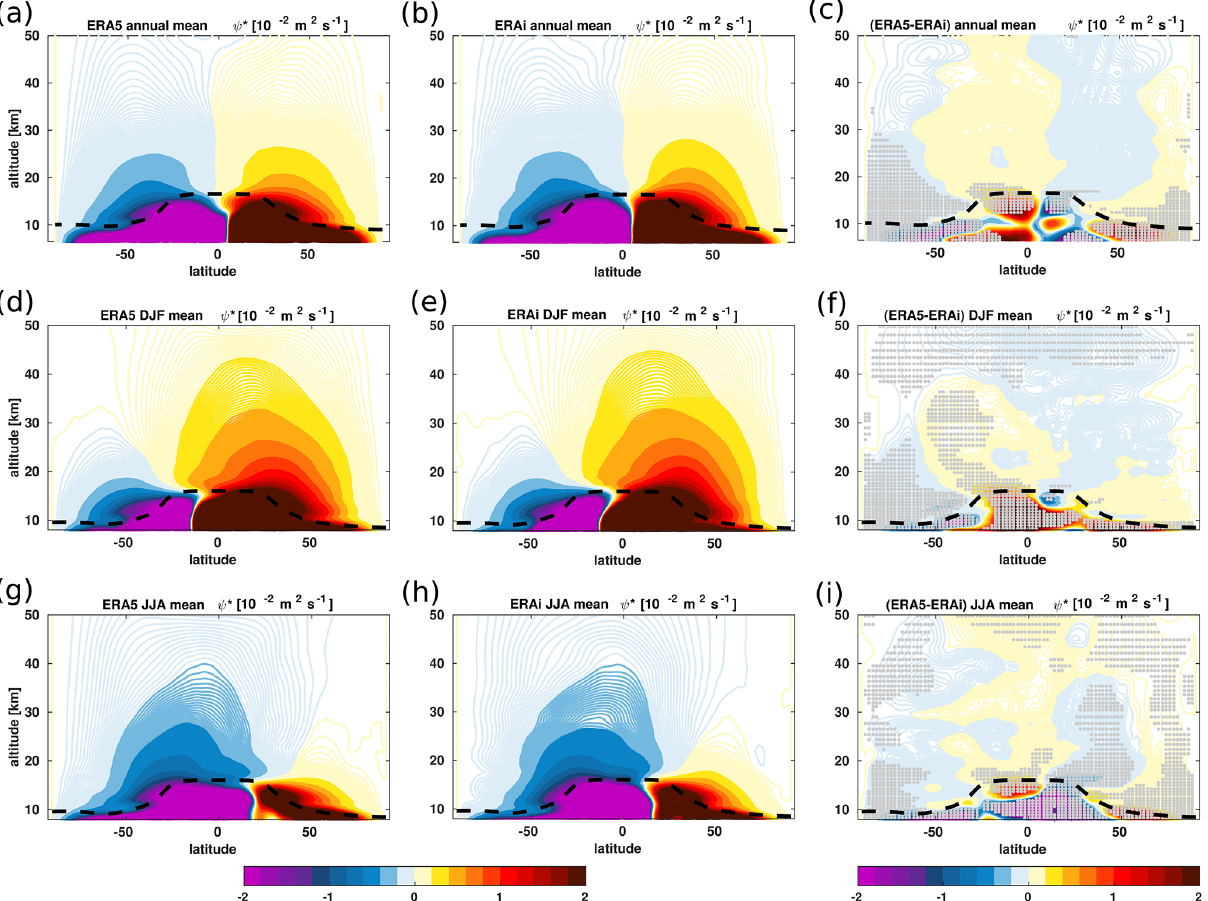
Figure 4. Zonal mean distribution of the annual (a, b) , DJF (d, e) , and JJA (g, h) mean variations of the residual stream function ( ψ ∗ in m 2 s − 1 ) from the ERA5 (left column) and the ERA-Interim (middle column) reanalyses together with the associated differences (c, f, i) between the ERA5 and the ERA-Interim reanalyses (right column) for the 1979–2018 time period. The contours in the left and middle panels are spaced by about 0.015m 2 s − 1 , and the contours in the right panel are spaced by about 0.005m 2 s − 1 . Grey dots in panels (c, f, i) indicate regions where the differences between the ERA5 and ERA-Interim reanalyses are statistically significant at 95% estimated using Student’s t test. The climatological tropopause from the ERA-Interim is indicated as the dashed black horizontal